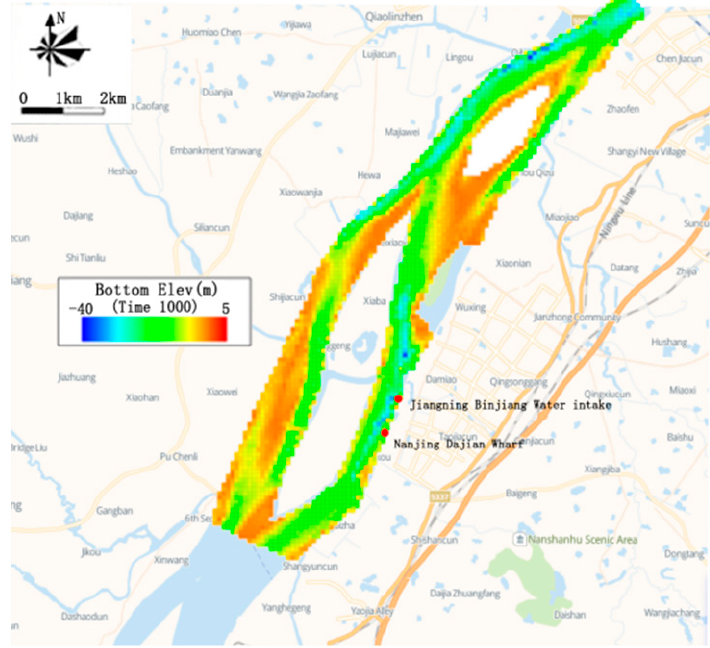
Figure 1. Calculation of the river area topography and grid layout.